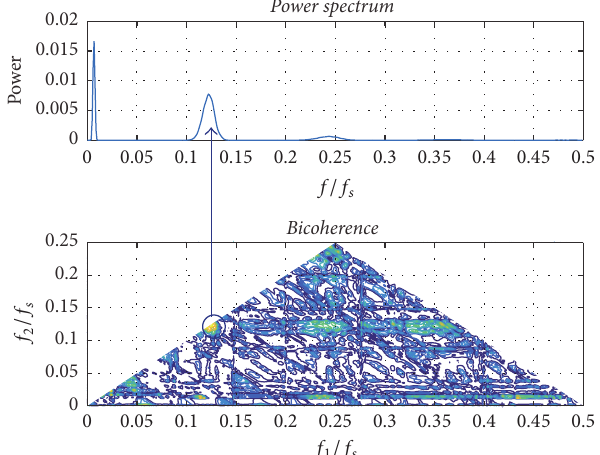
Figure 4: Contour of bicoherence for the novel system